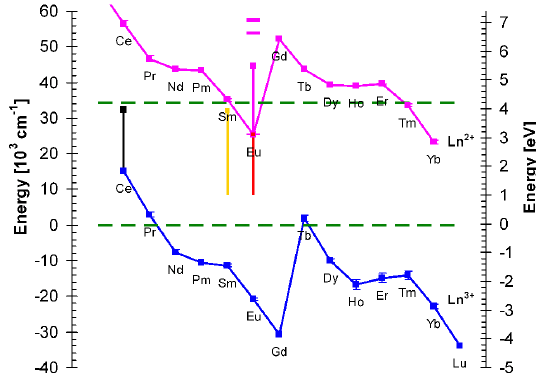
Figure 13. The proposed lanthanide energy level scheme in KLuS 2 at 77 K, description in text.